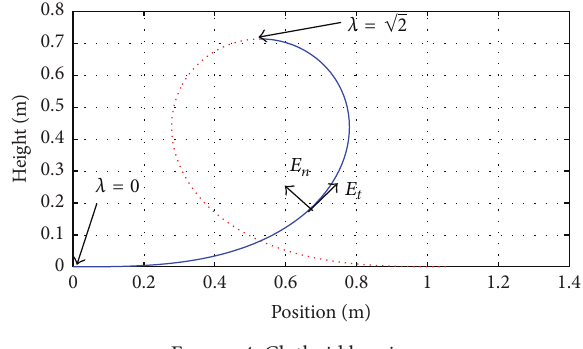
Figure 4: Clothoid